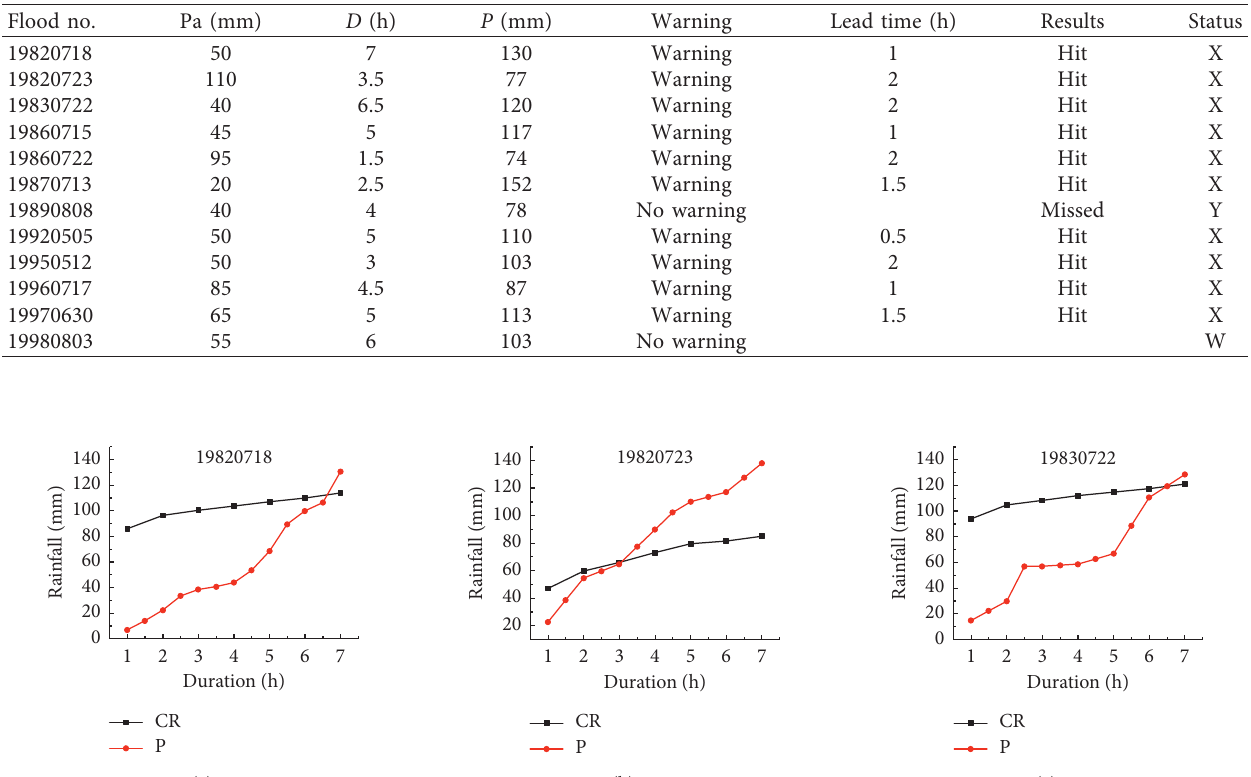
Table 6: Warning results of 12 flood